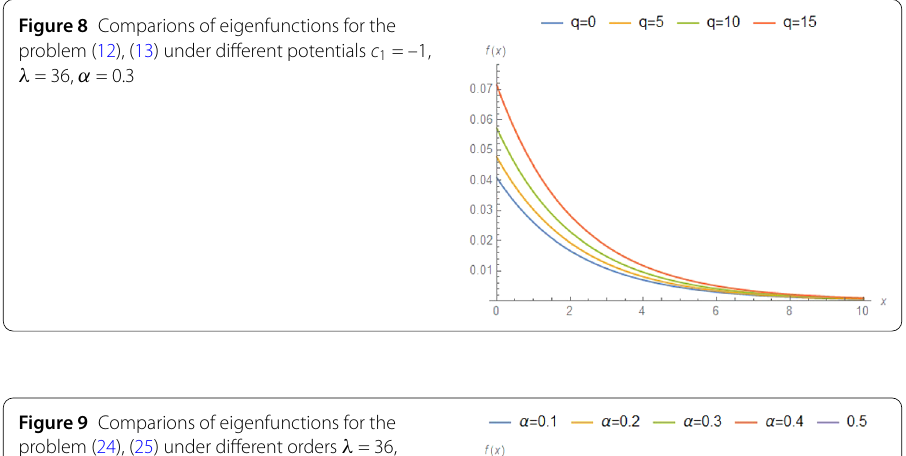
Figure 9 Comparions of eigenfunctions for the problem (24), (25) under different orders λ = 36, c 3 = –1, q = 0